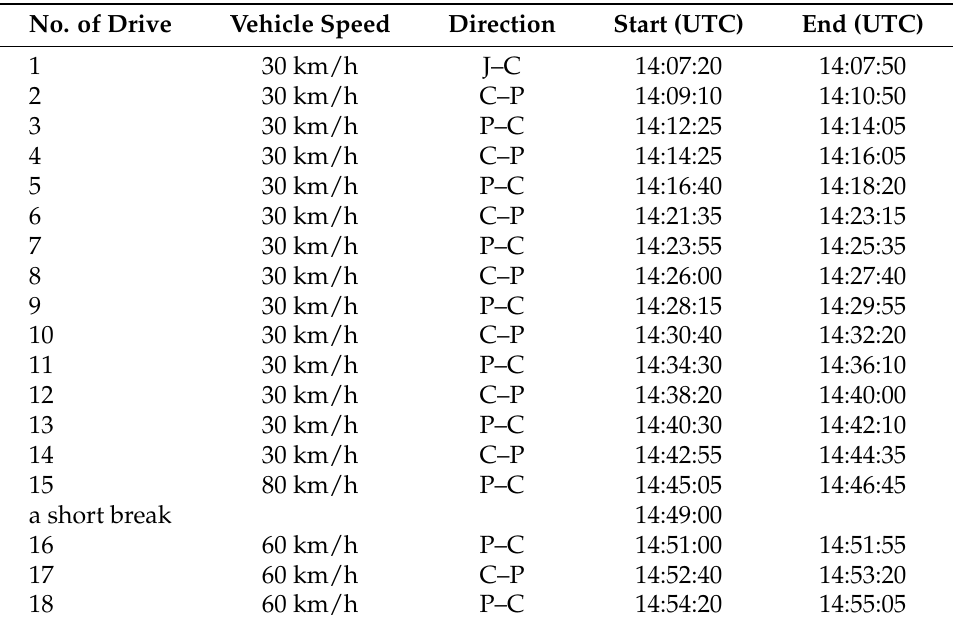
Table 2. Vehicle speed, direction and times for each test drive.